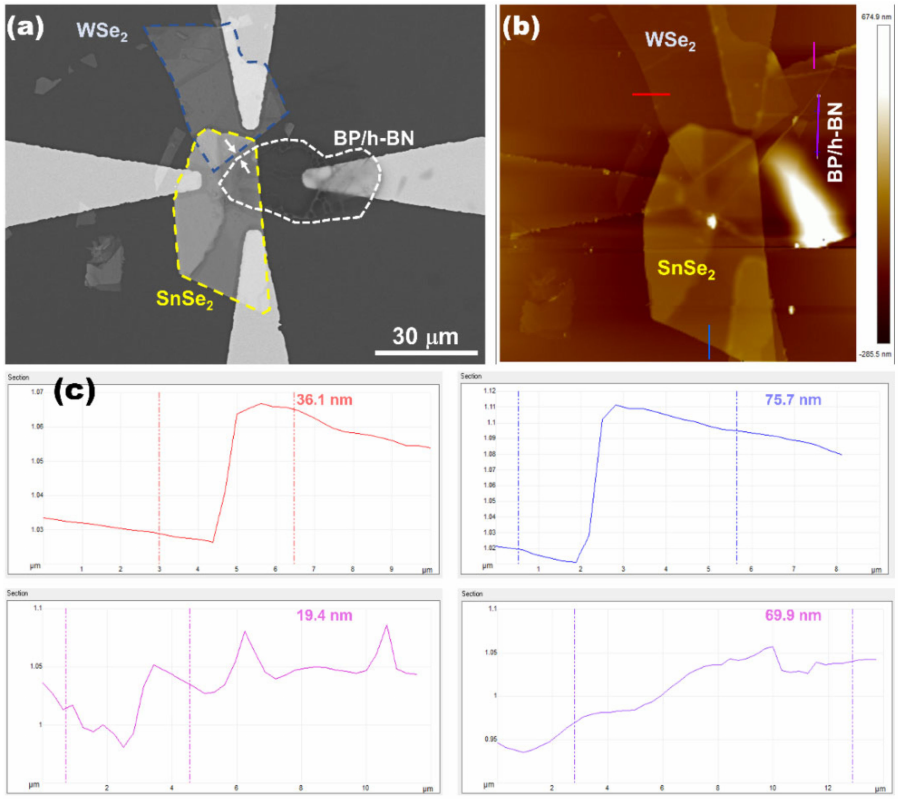
Figure 2. ( a ) SEM image and ( b ) AFM image of the BP-gated WSe 2 /SnSe 2 van der Waals heterostruc- ture. ( c ) Corresponding topographic analysis of WSe 2 , SnSe 2 , h-BN, and h-BN/BP junction.